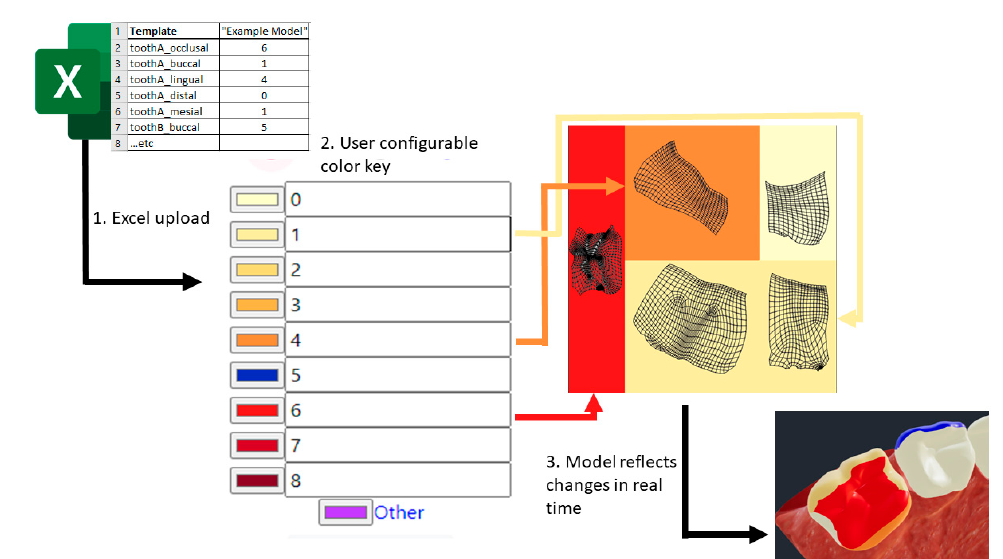
Figure 3. Process flow of data entry via a MS Excel template, its interpretation, and the customization of the process (i.e., color selection) via the web interface.